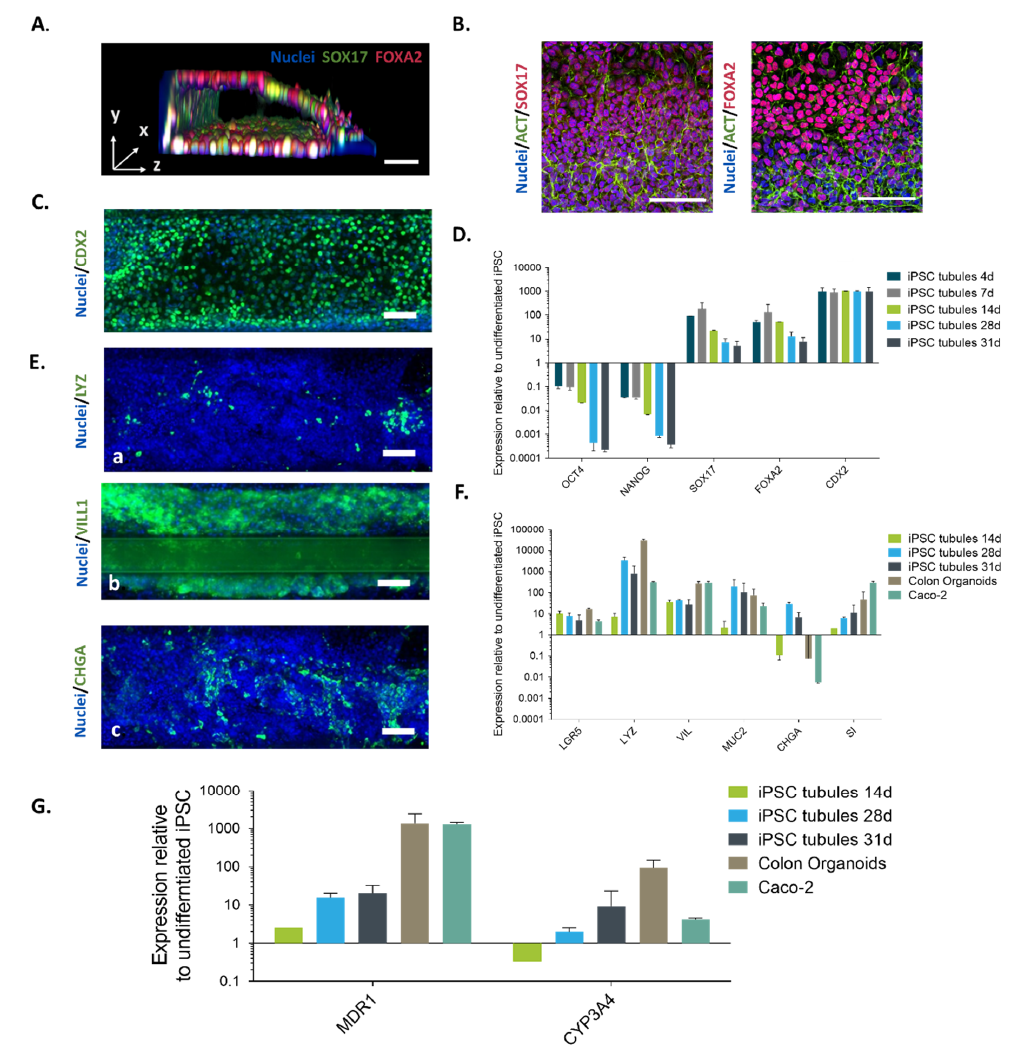
Figure 2. Characterization of hiPSC-derived human intestinal-like tubules. ( A ) 3D reconstruction image of an iPSC-derived tubule at Day 4 stained with antibodies for SOX17 (green), FOXA2 (red) or DAPI for DNA (blue). Cells attach and form tubule at the DE stage. ( B ) Representative images of iPSC tubules stained for Definitive endoderm markers SOX17 and FOXA2 at day 4. ( C ) Hindgut marker CDX2 at day 7. ( D ) Gene expression was measured using TaqMan qRT-PCR from hiPSC tubules at different differentiation stages. The following genes were analysed: POU class 5 homeobox 1 (POU5F1, indicating pluripotency); Nanog homeobox (NANOG, indicating Primitive Streak):, forkhead box a2 (FOXA2, Definitive Endoderm), SRY (sex determining region Y)-box 17 (SOX17, Definitive Endoderm), and Homeobox protein CDX-2 (Posterior gut). ( E ) Representative images of iPSC tubules stained for intestinal markers Lysozyme (LYZ), Villin (VIL) and Chromogranin A (CHGA) at day 28 (green). Nuclei were stained with DAPI (blue) to visualize the overall morphology. Scale bars = 100 µ m. ( F ) Relative gene expression analysis of Intestinal markers: Leucine-rich repeat-containing G-protein coupled receptor 5 (LGR5), Mucin-2 (MUC2), Lysozyme (LYZ), Villin-1 (VIL1), Chromagranin A (CHGA) and sucrase-isomaltase (SI). ( G ) Relative mRNA expression of MDR1 (P-gp) and CYP3A4 in iPSC-derived intestine-like tubules on day 14, day 28 and day 31, human adult colon organoids and Caco-2 cells. Expression levels were normalized to beta-actin (ACTB), data represented as mean ± SD relative to the expression in undi ff erentiated miFF1 hiPSC ( n = 2, n ≥ 2–3). The Y-axis represents the LOG10 relative quantification (RQ). Caco-2 cells and primary colon organoid were also included to compare gene expression and to follow the di ff erentiation of our model during the di ff erent stages. Data are presented as the average of two independent experiments +/ − SD ( n =